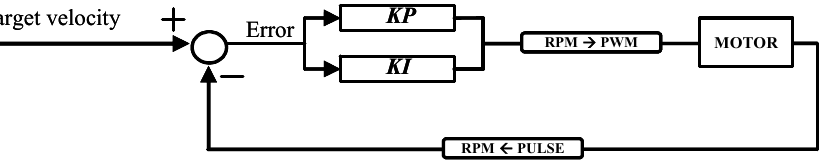
Figure 20. Detail of the PI controller implementation.